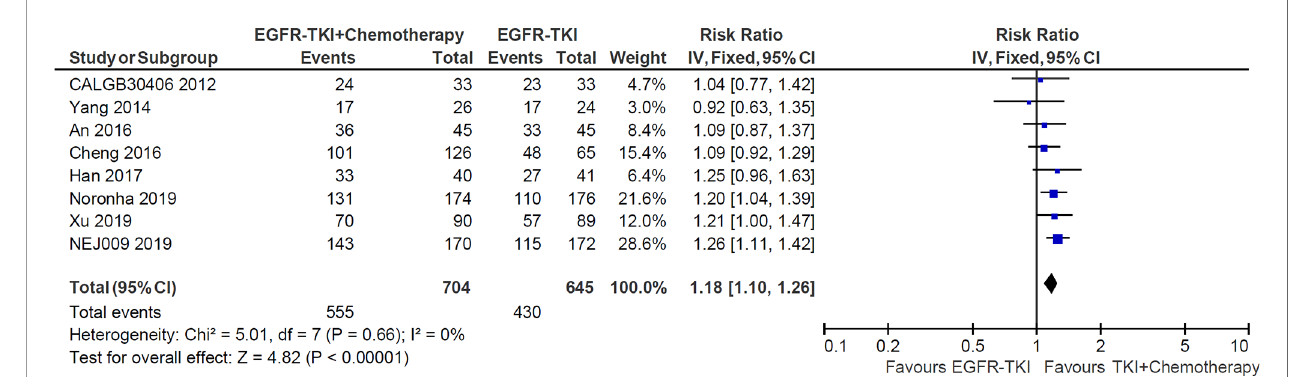
FIGURE 5 | Forest plot of Risk ratio of objective response rate in EGFR-TKI plus chemotherapy group and EGFR-TKI monotherapy group.